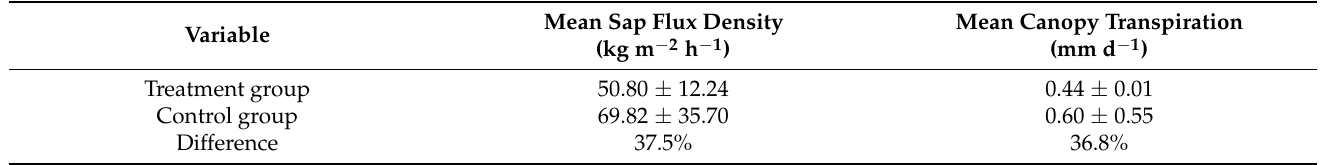
Table 5. Statistical results of two indexes between the treatment group and the control